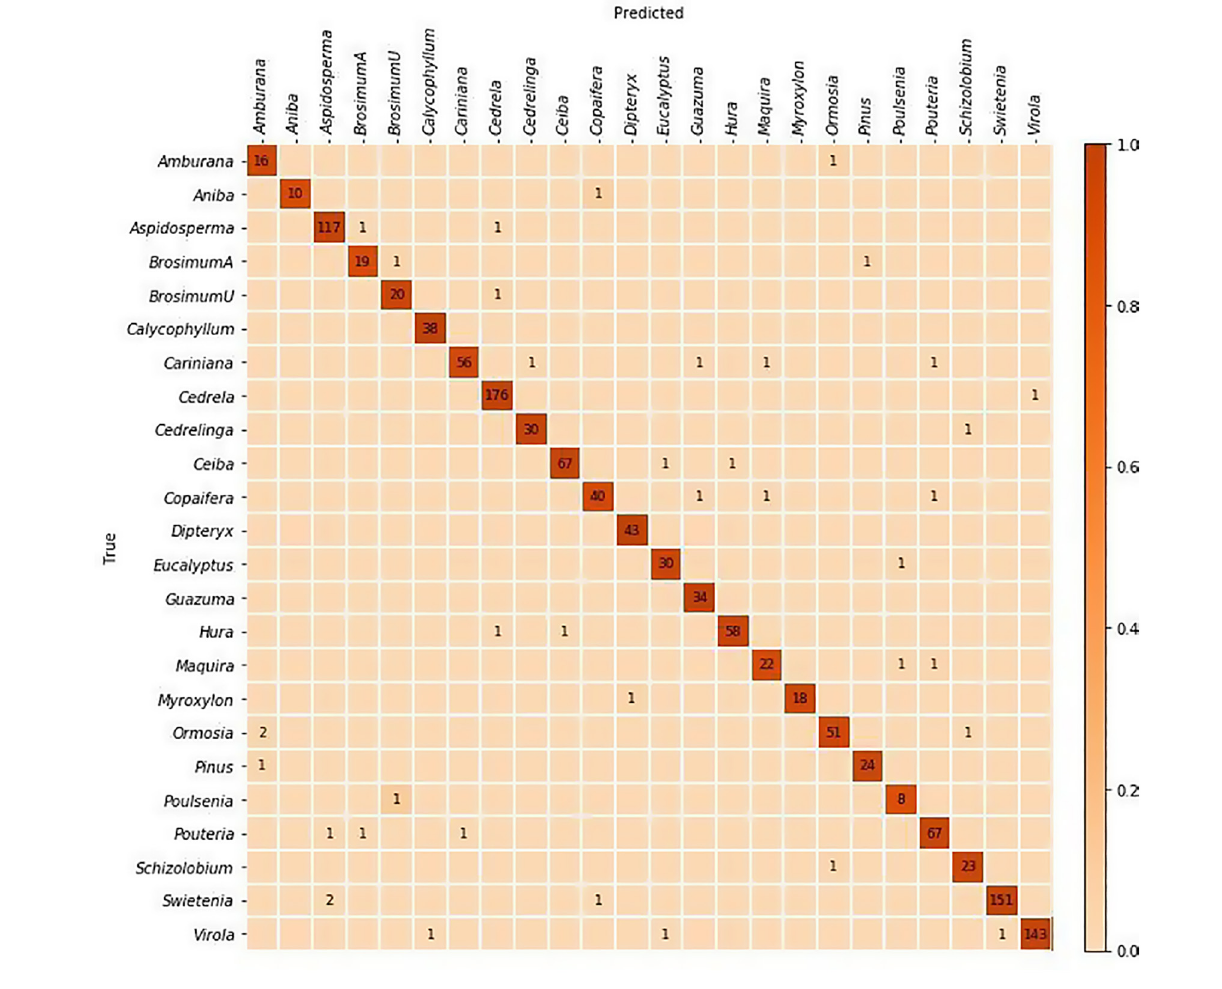
FIGURE 2 | Confusion matrix for the top-1 predictions of the five-fold cross-validation models. The specimen-level accuracy accumulated over the five folds was 97%. The majority of misclassifications are between anatomically similar